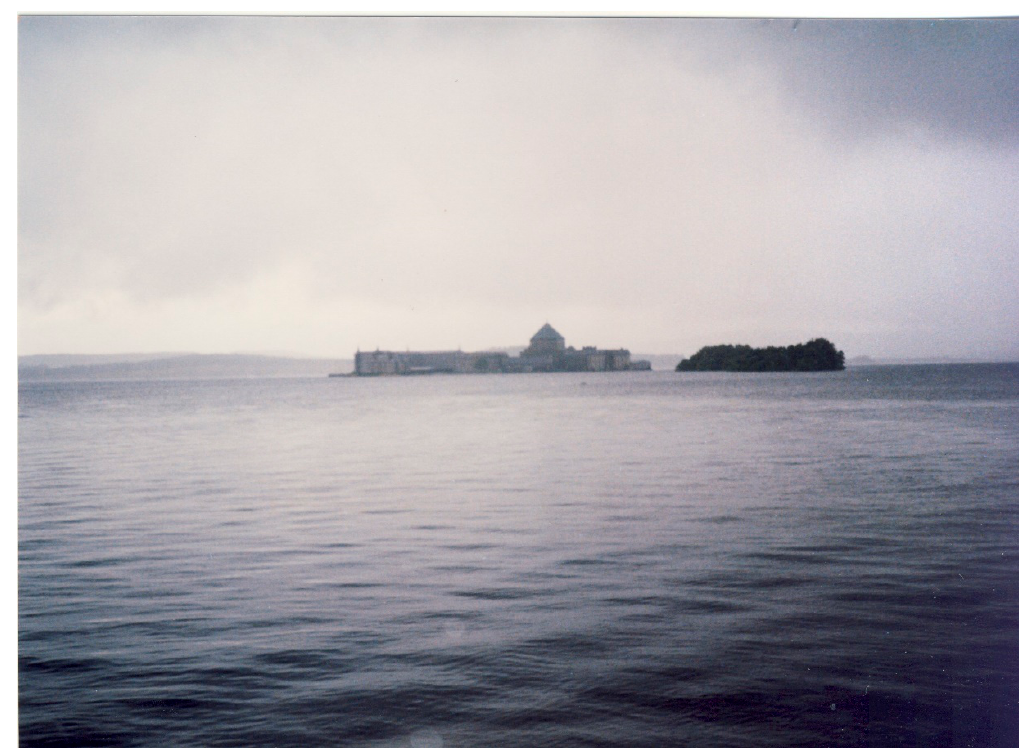
Figure 4. The Station Island in Lough Derg.